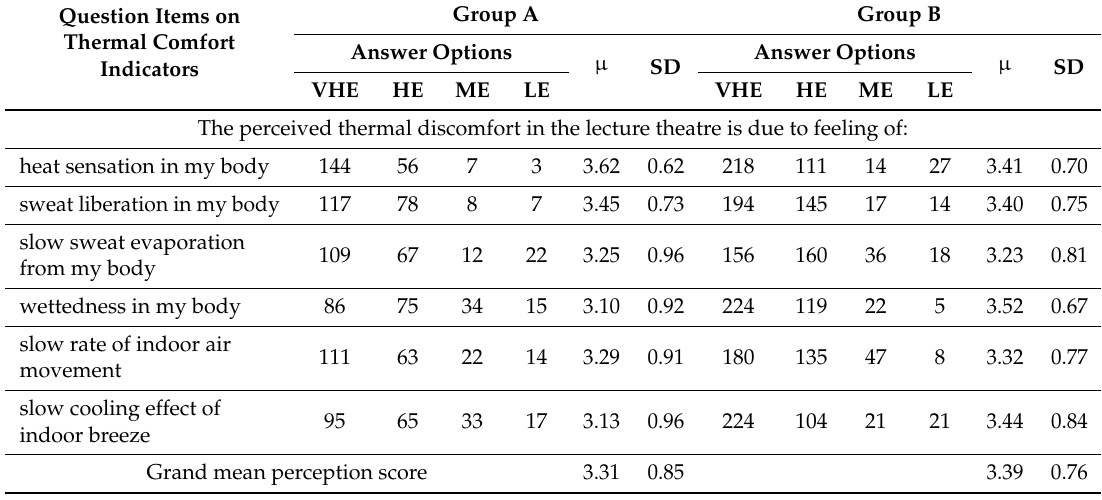
Table A1. Students’ Perceived Thermal Discomfort Levels in Lecture Theatres.